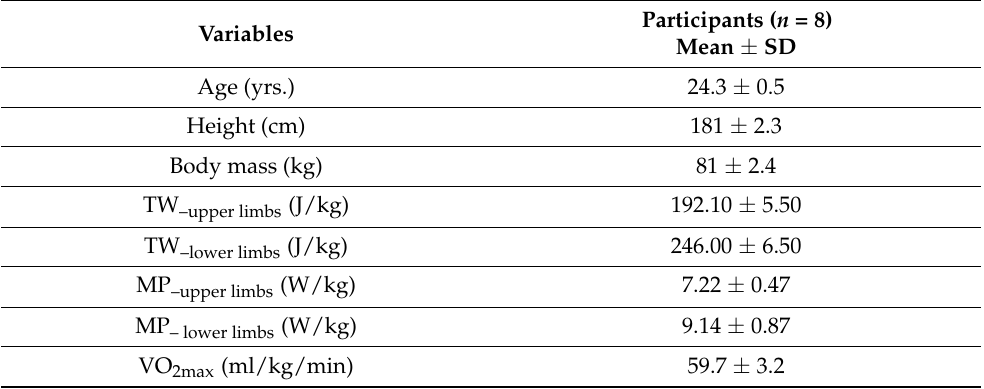
Table 1. Characteristics of the study